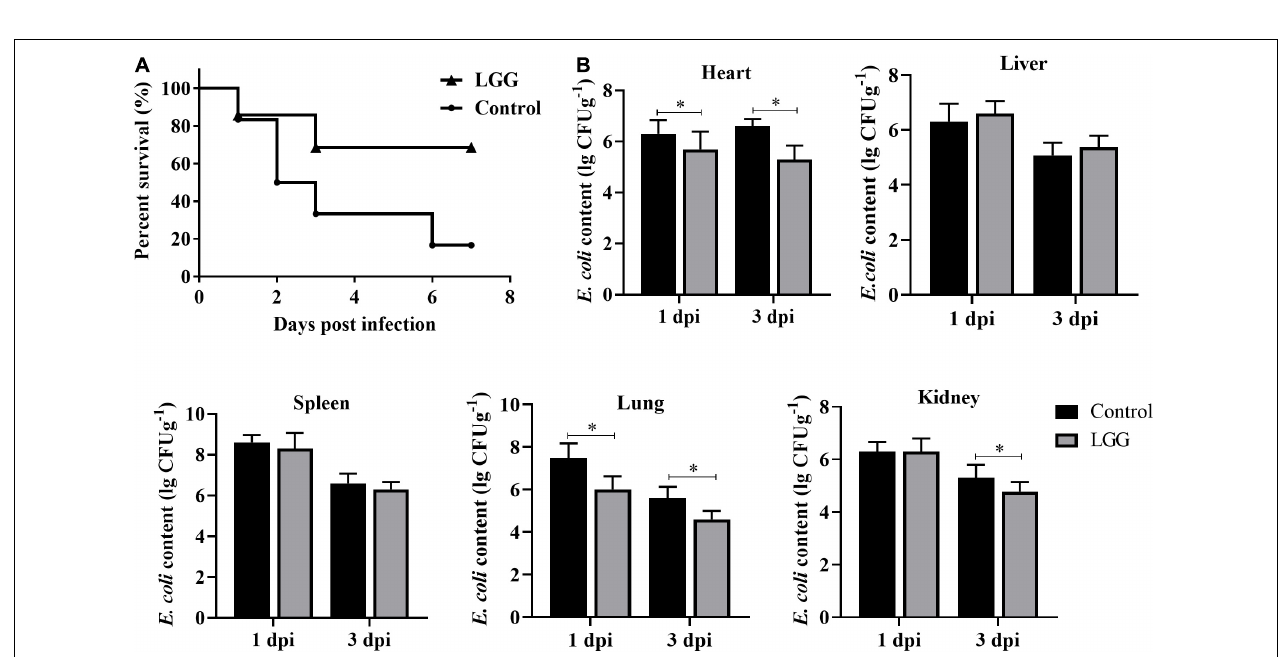
FIGURE 6 | Disease resistance of chickens fed with LGG diet post-challenge with E. coli . Chickens were challenged with 10 6 CFU E. coli after 21 days of feeding. (A) The survival rate of chickens after infection with E. coli . (B) E. coli content in hearts, livers, spleens, lungs, and kidneys of infected chickens at 1 and 3 dpi (log 10 CFU g - 1 ). Bars represent the means ± standard deviations ( n = 5). * p < 0.05.